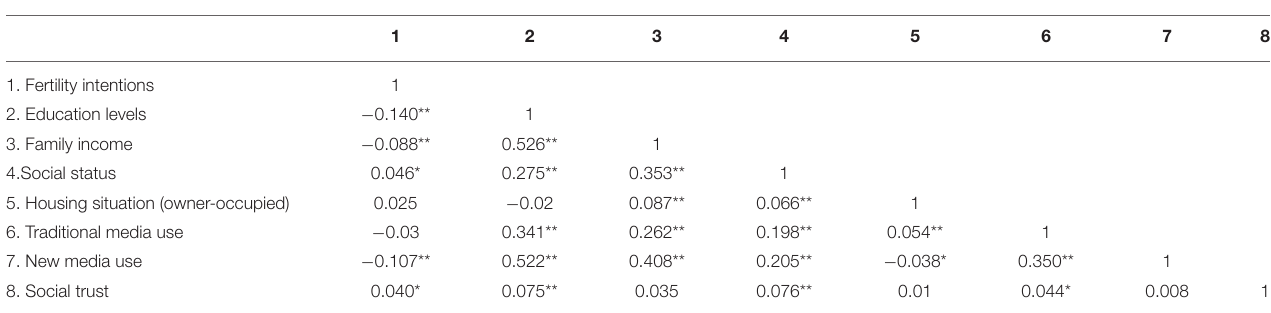
TABLE 4 | Bivariate correlation between the